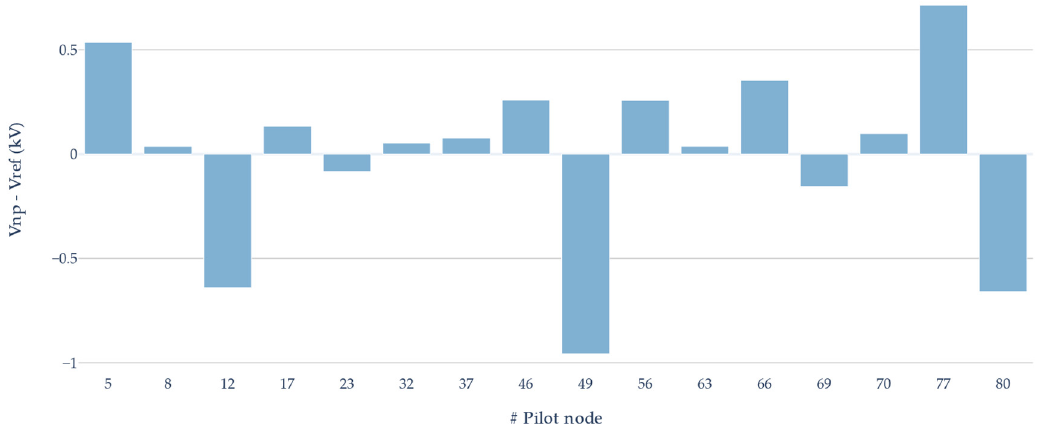
Figure 8. Maximum error between reference and optimized voltage in pilot nodes (kV) for the IEEE 118-bus test system.